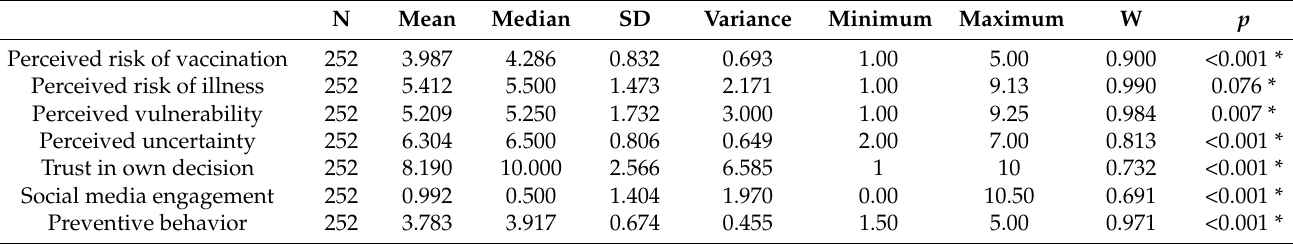
Table 2. Predictors normality